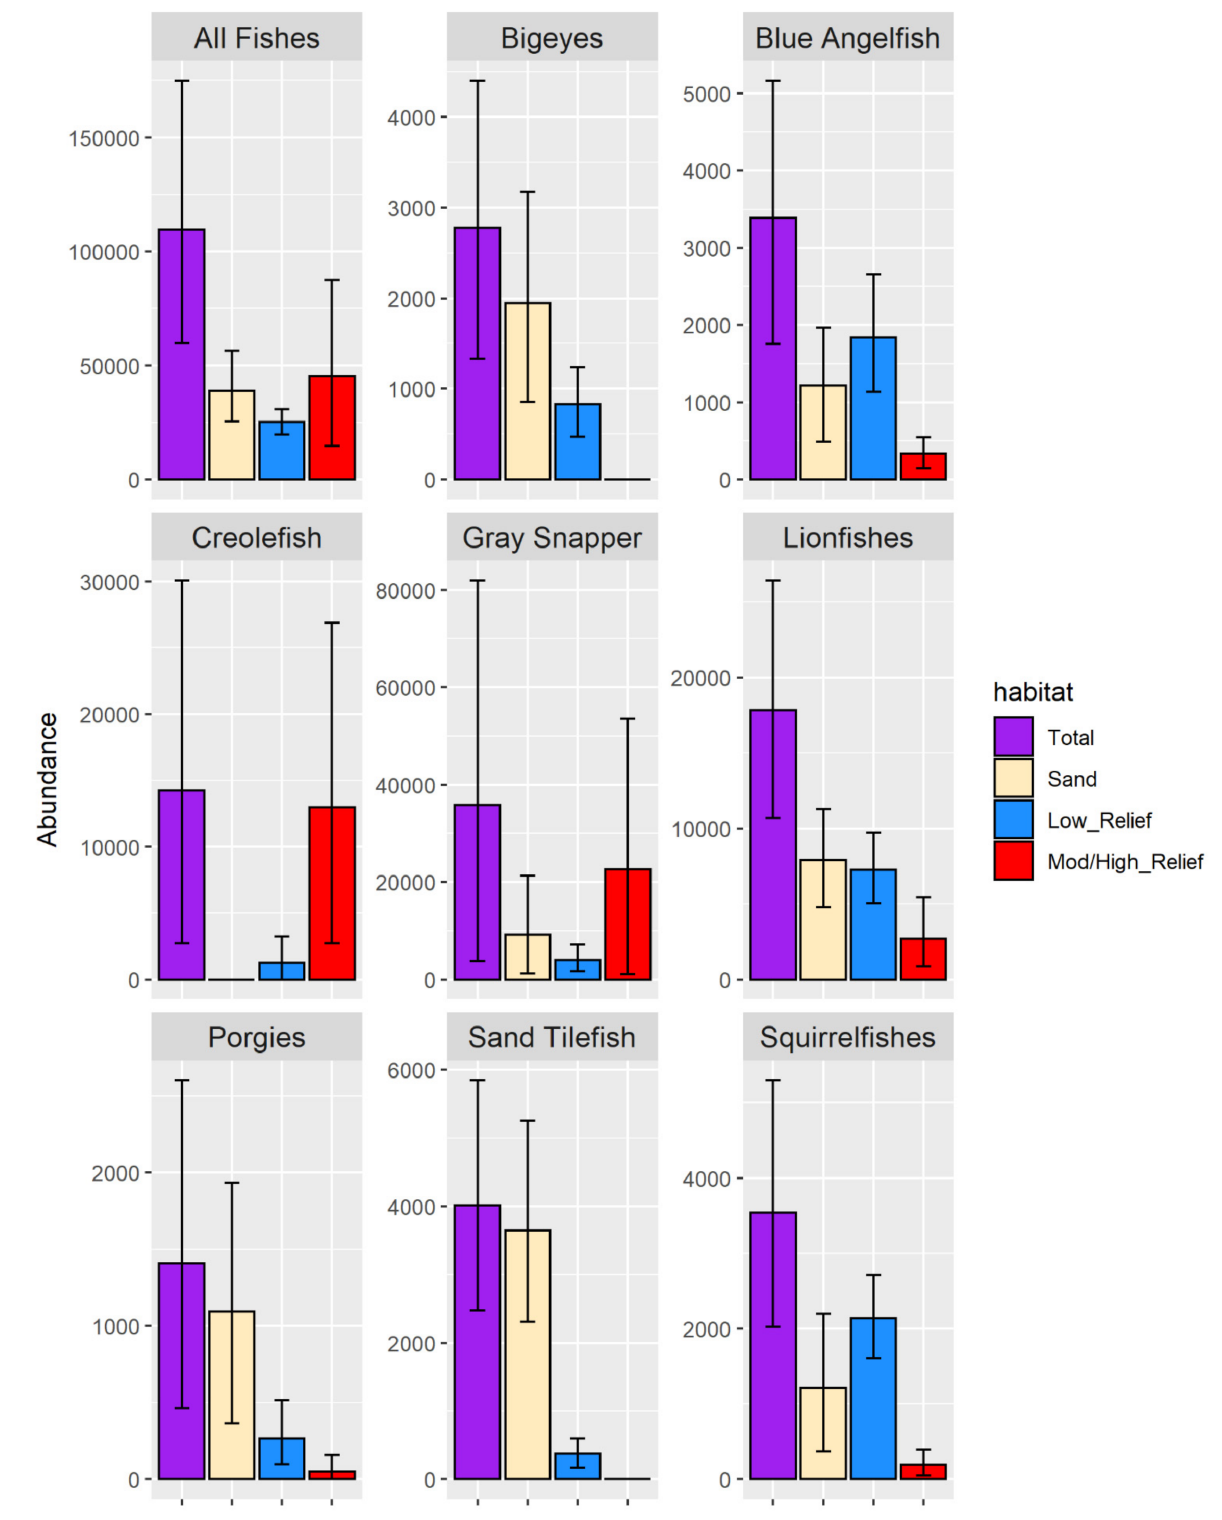
Figure 15. Estimates of total abundance for select fish taxa within the portion of Elbow on the west Florida shelf that was mapped using a MBES. The calculated contributions of sand, low relief rock, and moderate to high relief rock to the estimated total abundances are also shown. Extrapolations are based on the area of each habitat as determined by the combined substrate and vertical relief map using the supervised methodology (Figure 12) and the habitat-specific densities for each taxon (Table A1 and Figure 13). Error bars represent the 95% bootstrap confidence